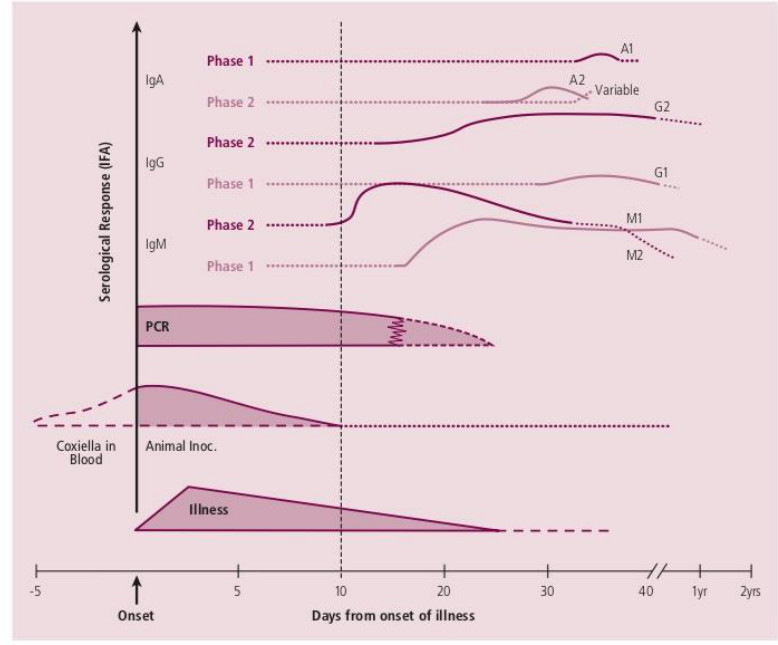
Figure A2. Acute Q fever infection, bacteraemia, and serological responses